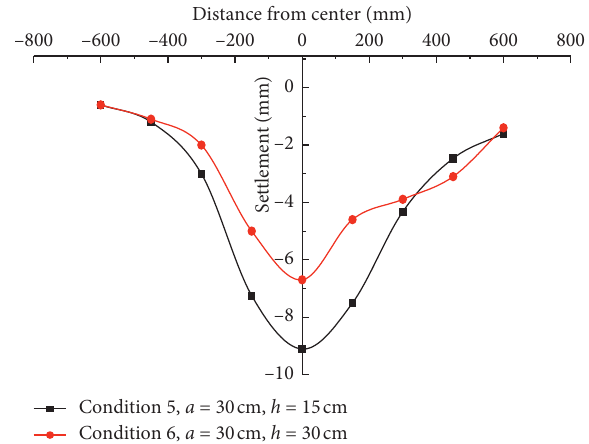
Figure 12: Influence of the thickness of the overlying soil layer on the settlement tank of the pipeline. Table 5: Experiment 4 and 5 cavity parameter